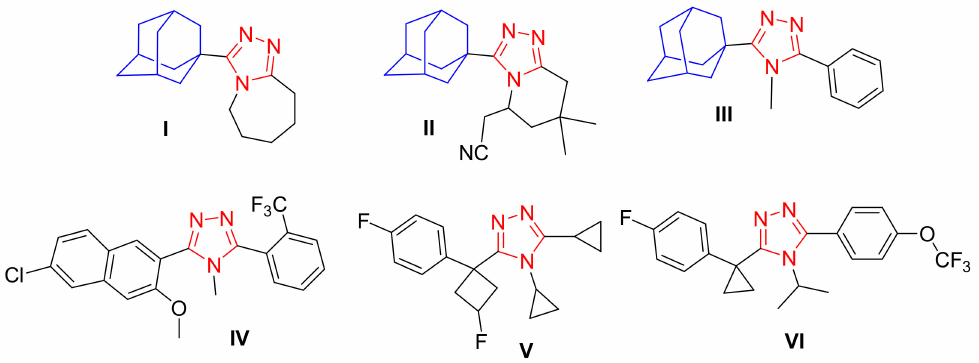
Figure 1. The structures the adamantyl-1,2,4-triazoles ( I – III ) and non-adamantyl-1,2,4-triazoles ( IV – VI ) 11 β -HSD1 inhibitors.